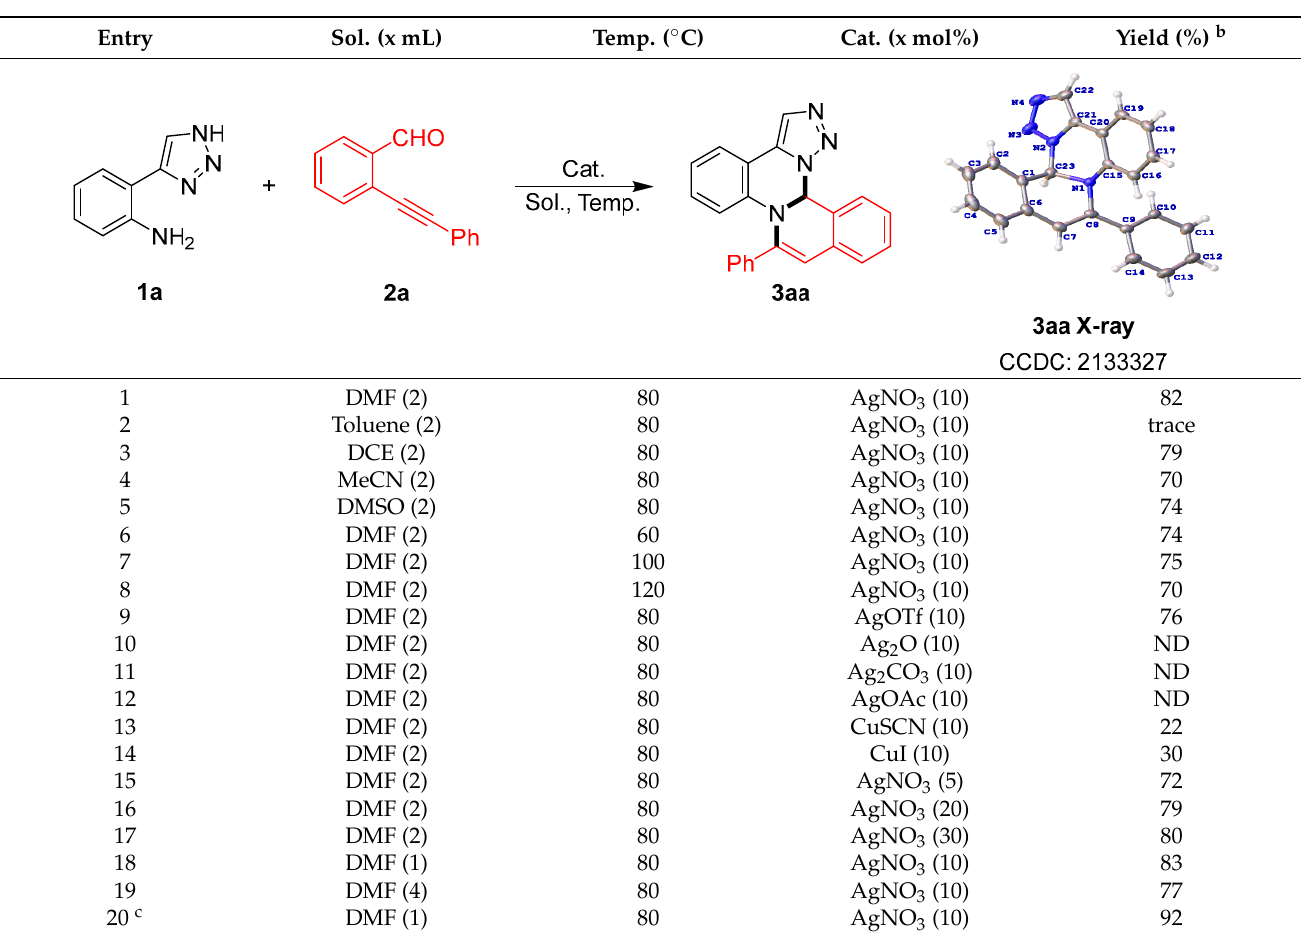
Table 1. Optimization of the reaction conditions a .